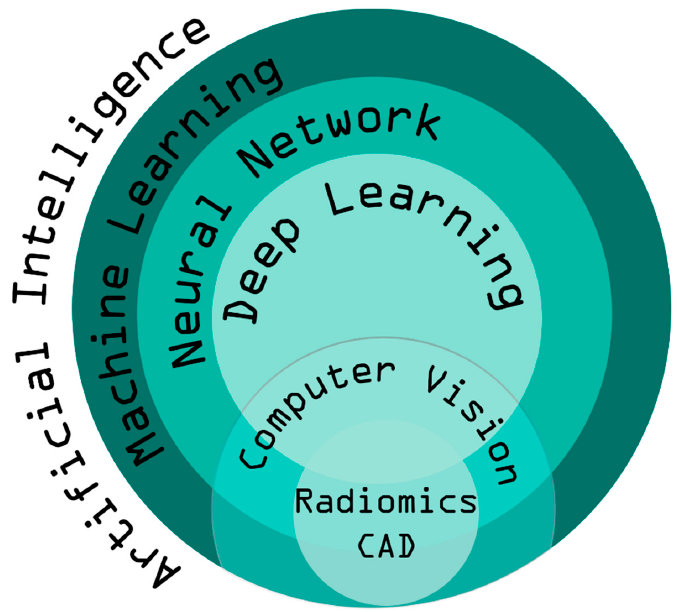
Figure 1. The four terms related to AI and their interrelationship in radiology.